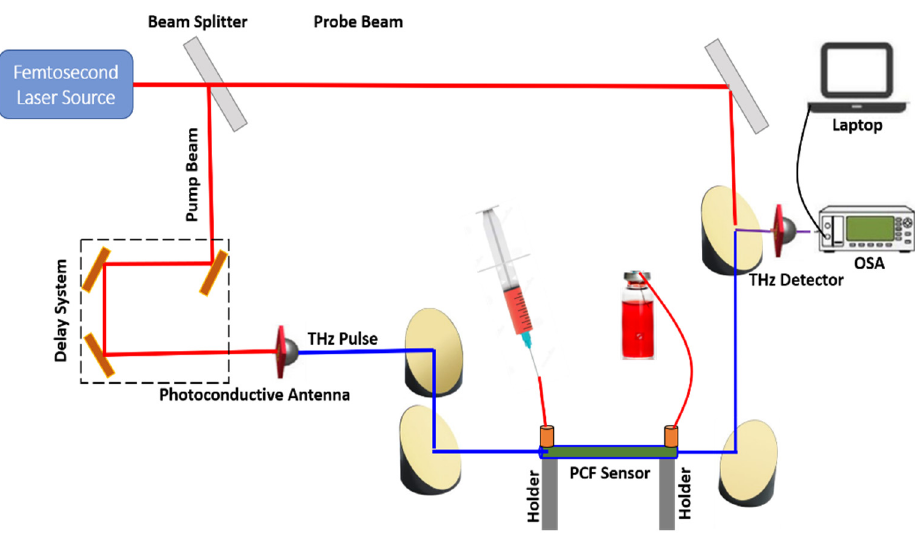
Figure 2. Schematic diagram of the experimental setup of the proposed sensor for practical sensing application. sensing